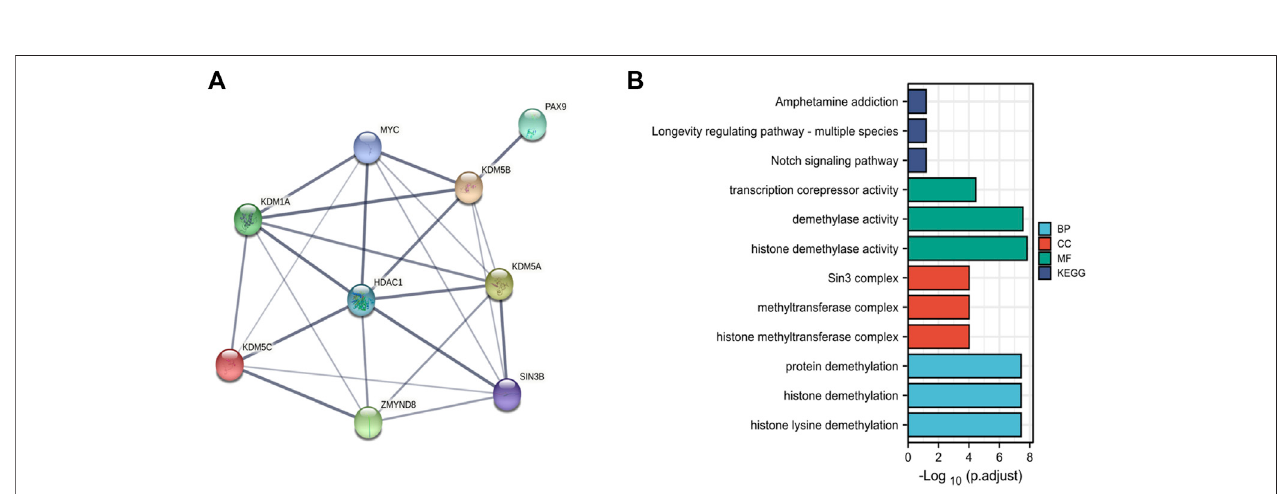
FIGURE 6 | PPI and functional enrichment analysis of the KDM5 family and related genes in patients with PAAD. (A) The PPI network associated with the KDM5 family in pancreatic cancer; (B) The GO and KEGG pathway terms of the 9 genes with the strongest interaction with KDM5 family proteins.).